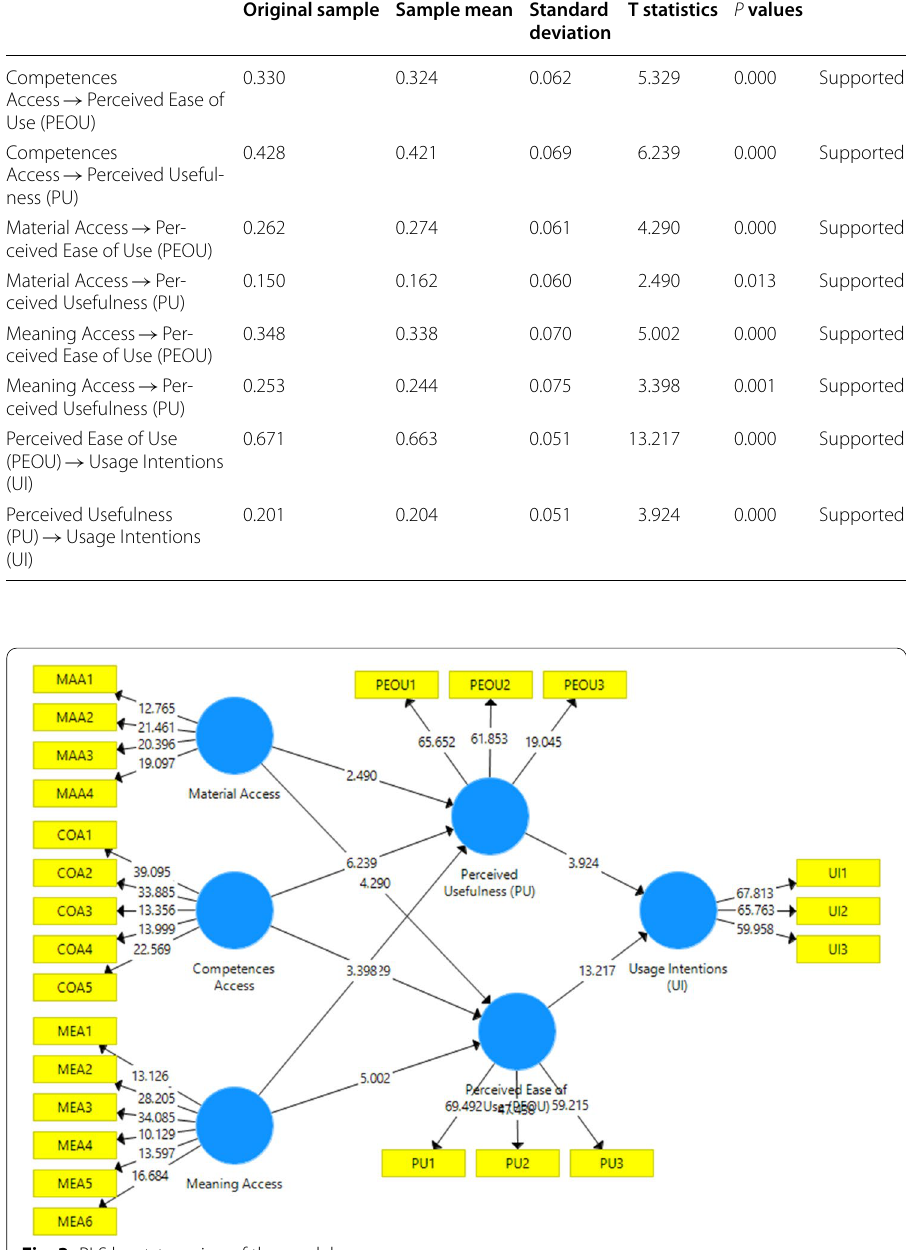
Table 5 Path coefficient of the